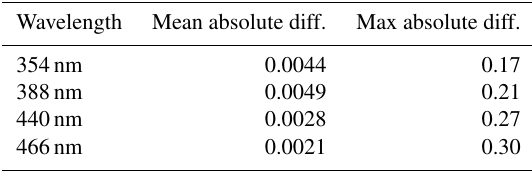
Table 6. Sensitivity to wind speed and